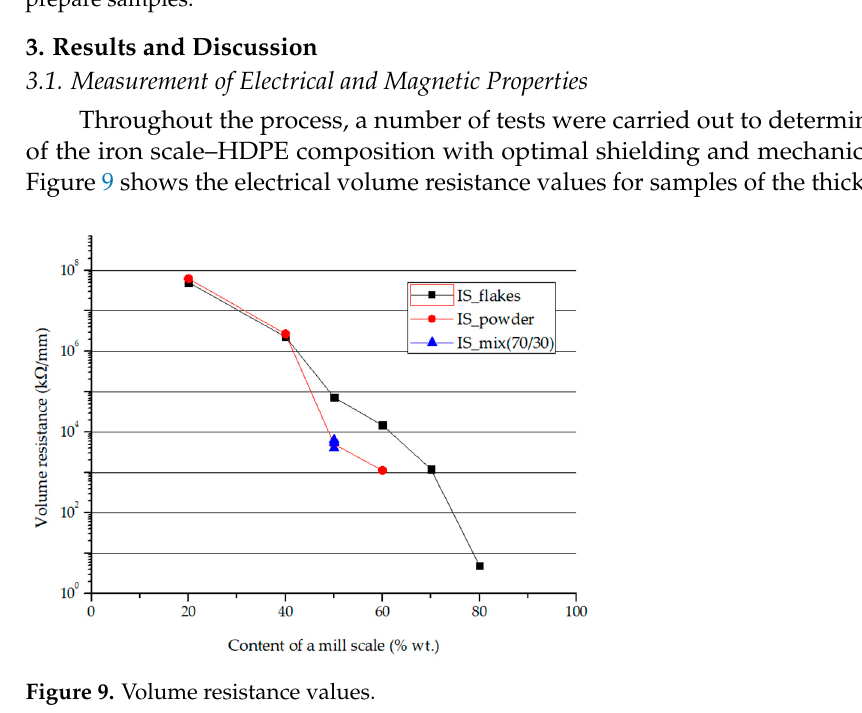
Figure 8. Stand for the production of samples, ( a ) an example of a mold and ( b ) a press used to prepare samples.